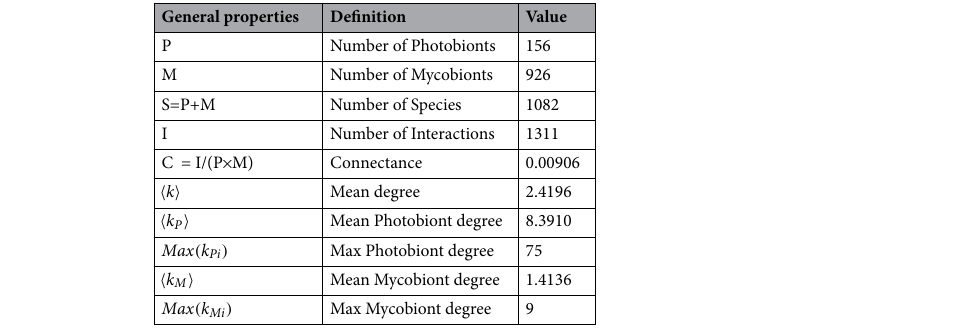
Table 1. General properties of the photobiont-mycobiont network.